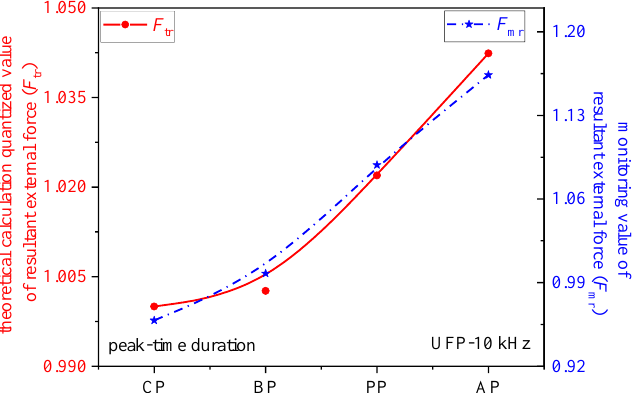
Figure 3. Comparison between theoretical and monitoring value of droplet resultant external force.